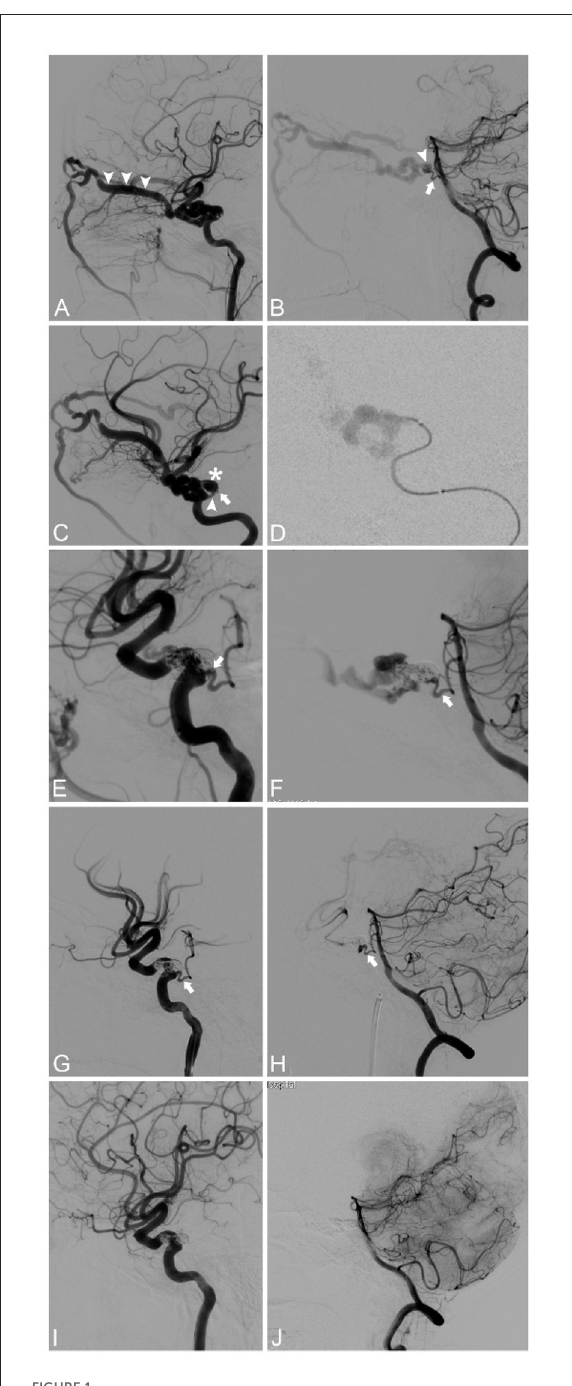
FIGURE1 (A) Lateral view of the left ICA angiography showing a CCF with dilated SOV (arrowhead). (B) Lateral view of the right VA angiography showing the retrograde blood flow (arrow) from a ruptured PPTA aneurysm (arrowhead), projecting into the left CS. (C) The optimal projection for PPTA emitting (arrowhead) from left ICA, the PPTA aneurysm (asterisk), and the distal orifice (arrow) of PPTA connecting to BA. (D) The fistula was confirmed by super-selective angiography. (E,F) Partial embolization of